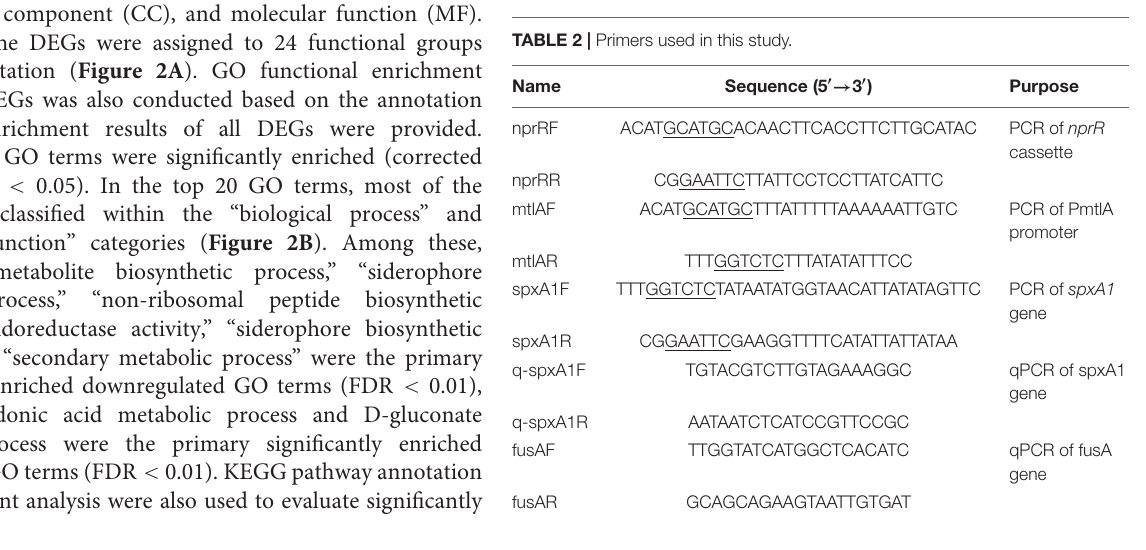
were significantly upregulated (red in Figure 1 ) in the